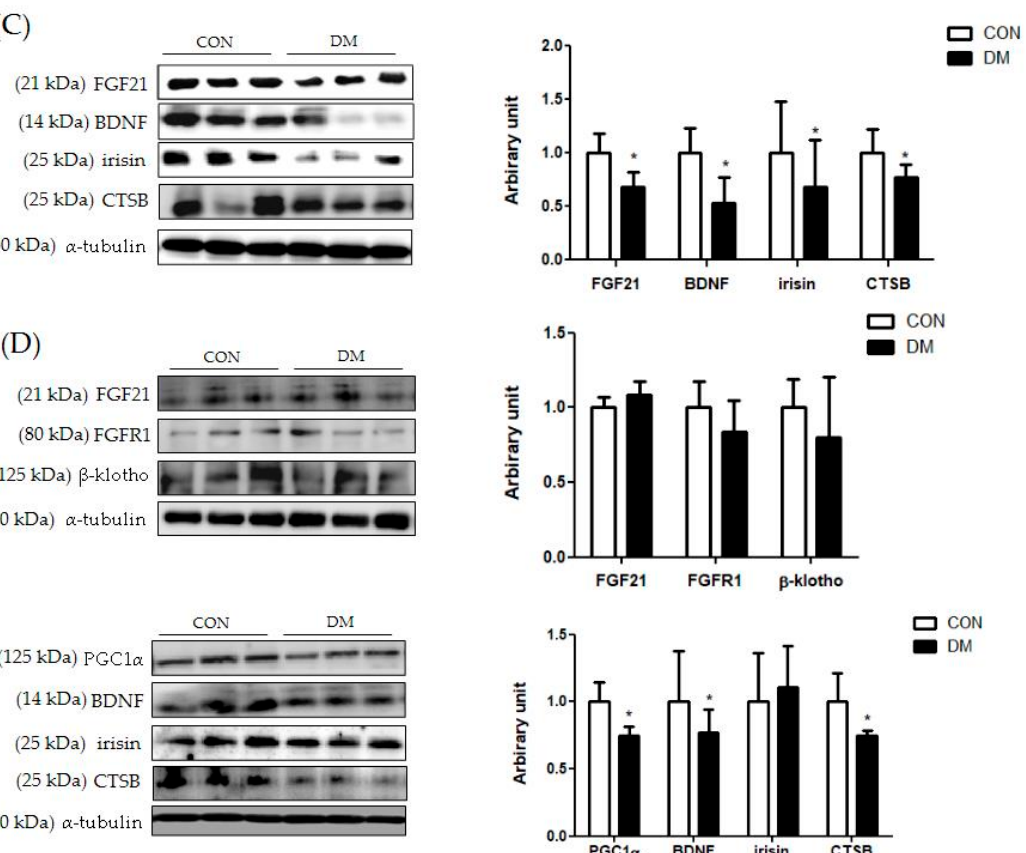
Figure 7. Energy metabolism related markers with myokines/hepatokines and neuronal markers in T2DM mice ( A ) liver ( B ) skeletal muscle, ( C ) plasma, and ( D ) hippocampus. All values are reported as mean and SD. The asterisk represents the statistical significance of differences from * p < 0.05. n = nine mice in each group. CON, normal control mice; DM, diabetes mellitus mice.